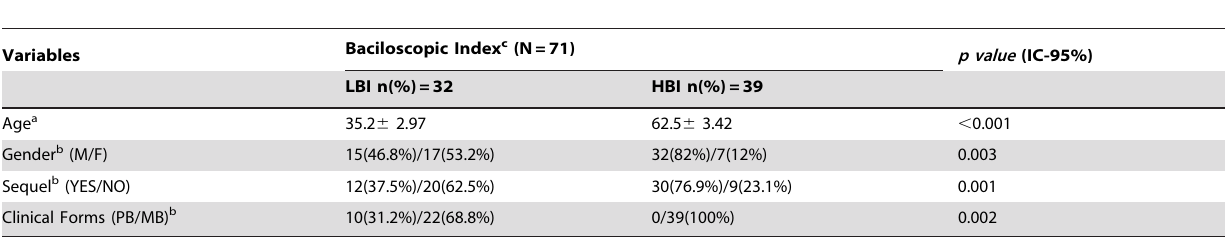
Table 1. Demographic and clinical characteristic of the sample according with Baciloscopic Index.